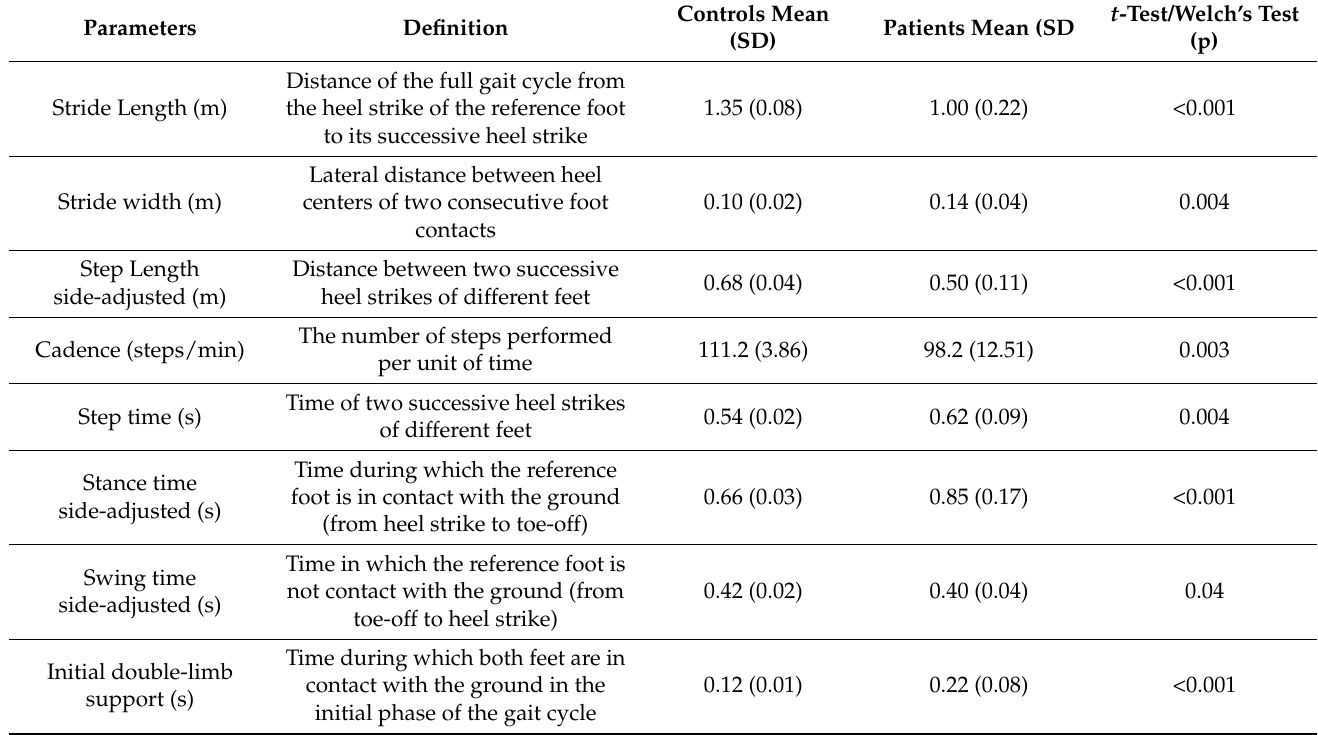
Table 2. Spatiotemporal gait parameters of both